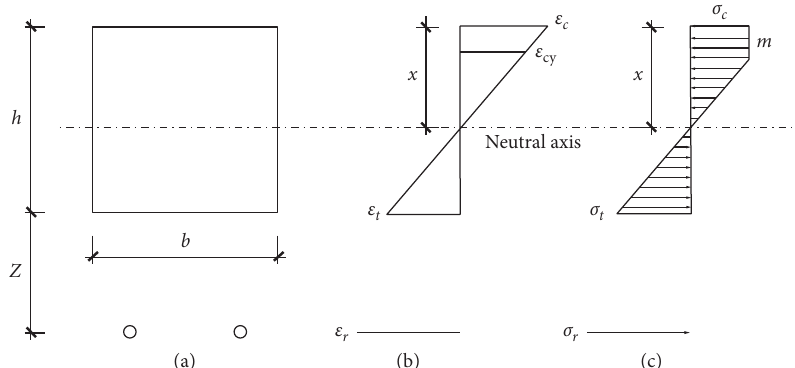
Figure 15: Calculation diagram of the failure of the prestressed glulam beam. (a) Computing model. (b) Strain diagram. (c) Stress diagram. Table 4: Comparison of the calculation value and the test value of the flexural bearing capacity. Group f y (N/mm 2 ) SPF-1.1 350.00 SPF-1.2 400.00 SPF-1.3 450.00 SPF-2.2